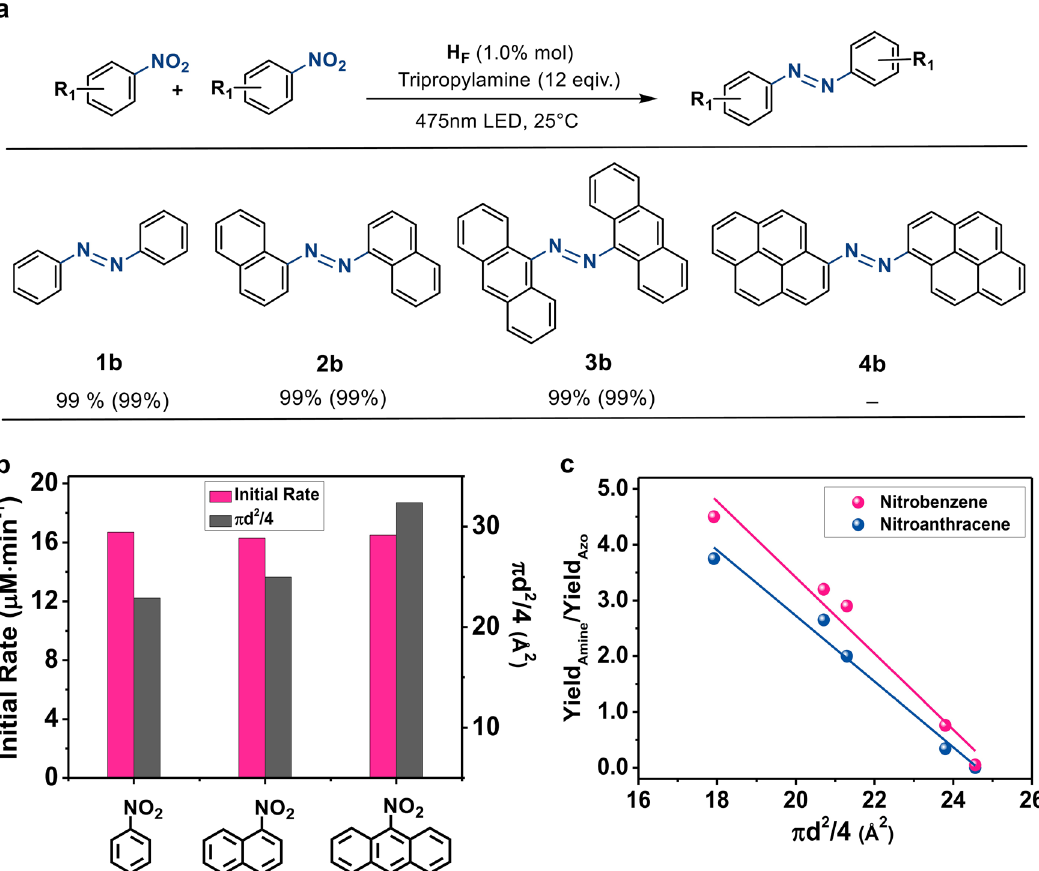
Fig. 5 Photoreduction of nitroarenes into azo products. a Photoreduction of nitroarenes into azo products under standard conditions: 1.0 mol% H F , substrates (0.05 mmol) and tripropylamine (0.60 mmol) at 25 °C in 5 mL CH 3 CN/H 2 O (4:1 in volume) under 475 nm LED irradiation for 6 h. The isolated yields were measured by 1 H NMR with the selectivity in parentheses. b The initial rate of azo conversion as a function of the estimated diameter of different substrates under standard conditions. c The relationship of the ratio between the yield of amino and the yield of azo products as a function of the estimated diameter (shown as π d 2 /4) of electron donors for the reduction of nitrobenzene and